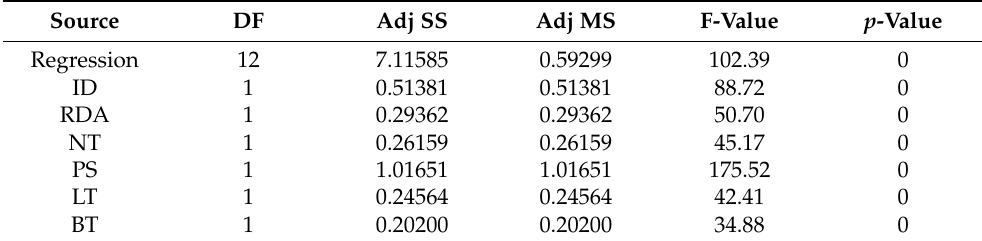
Table 5. Polynomial ANOVA, weight vs. ID, RDA, NT, PS, LT, BT. Source